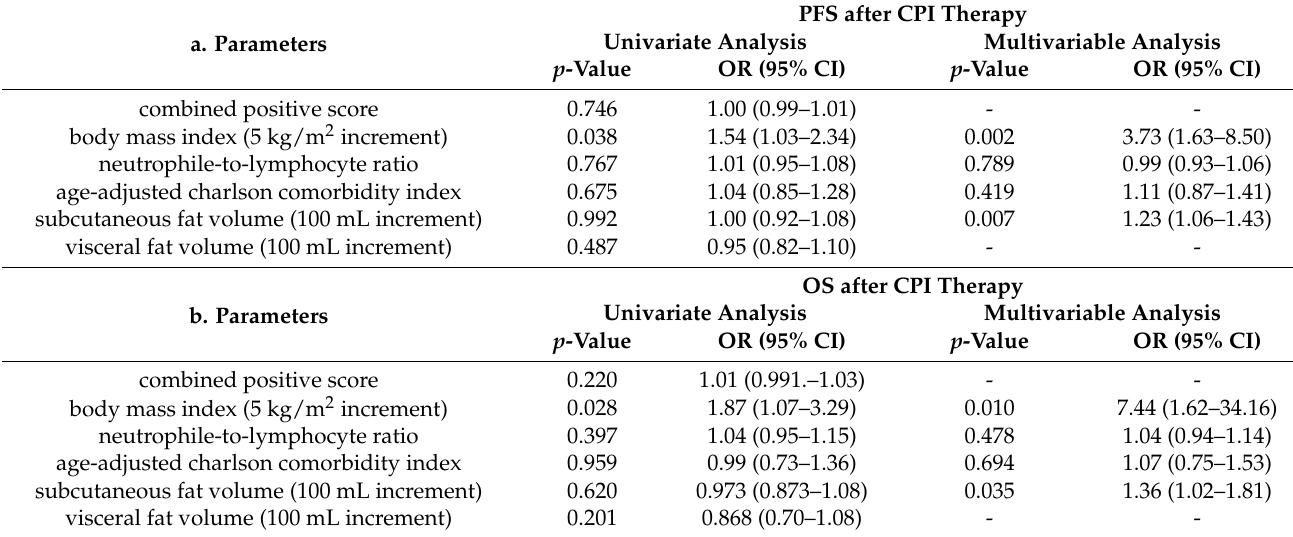
Table 3. Univariate and multivariate Cox-regression analysis of parameters prognostic for PFS ( a ) and OS ( b ) at the timepoint of pembrolizumab therapy initiation.